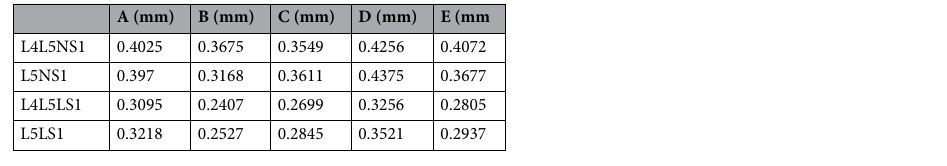
Table 3. Displacement of the upper surface of the sacrum.